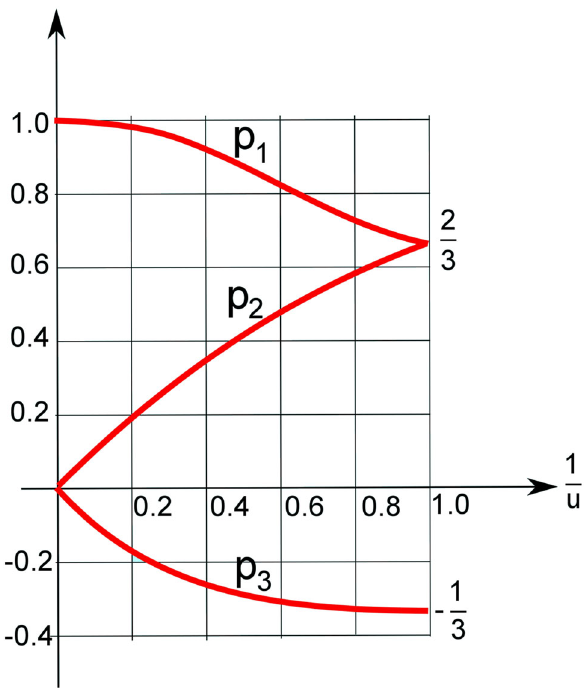
Fig. 1 Kasner indices as functions of the inverse of the u parameter. This figure was taken from [54] and is released under CC BY-SA 3.0